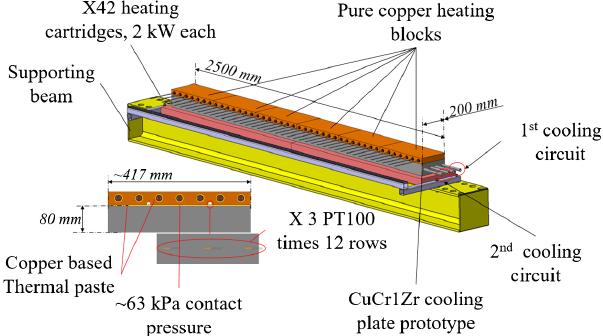
FIG. 17. Components of the cooling test bench and the respective configuration.